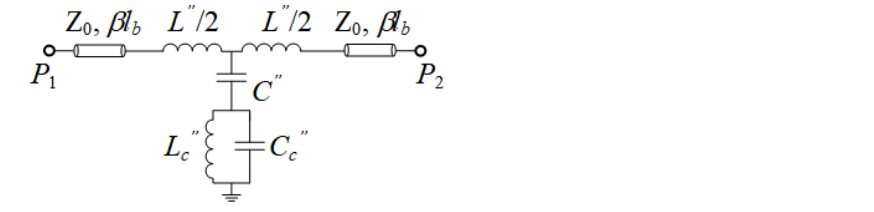
Figure 5. Circuit model of the microstrip line loaded with the folded and rotated (90°) DB-DGS resonator.